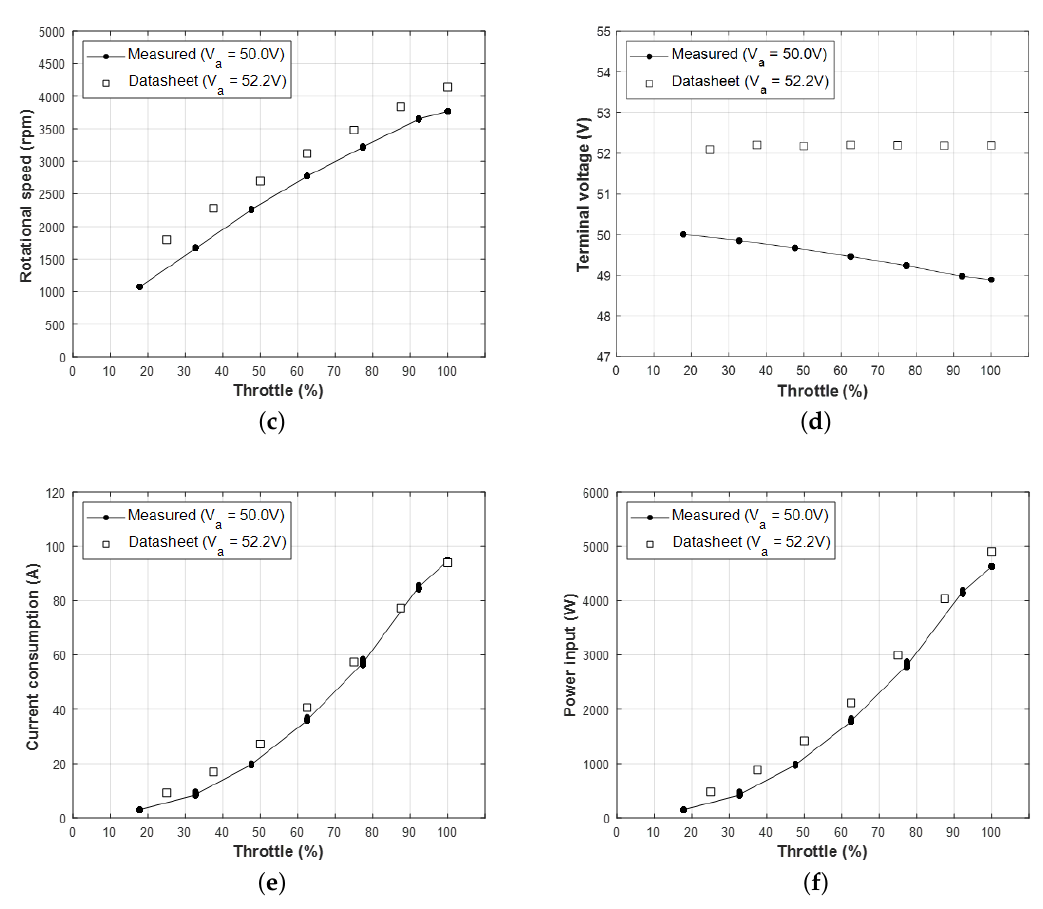
Figure 19. Static thrust test results of sample set 2 (KDE13218XF-105 with KDE-CF-355-DP) compared with datasheet: ( a ) Thrust, ( b ) torque, ( c ) rotational speed, ( d ) terminal voltage, ( e ) current consumption, and ( f ) power input.